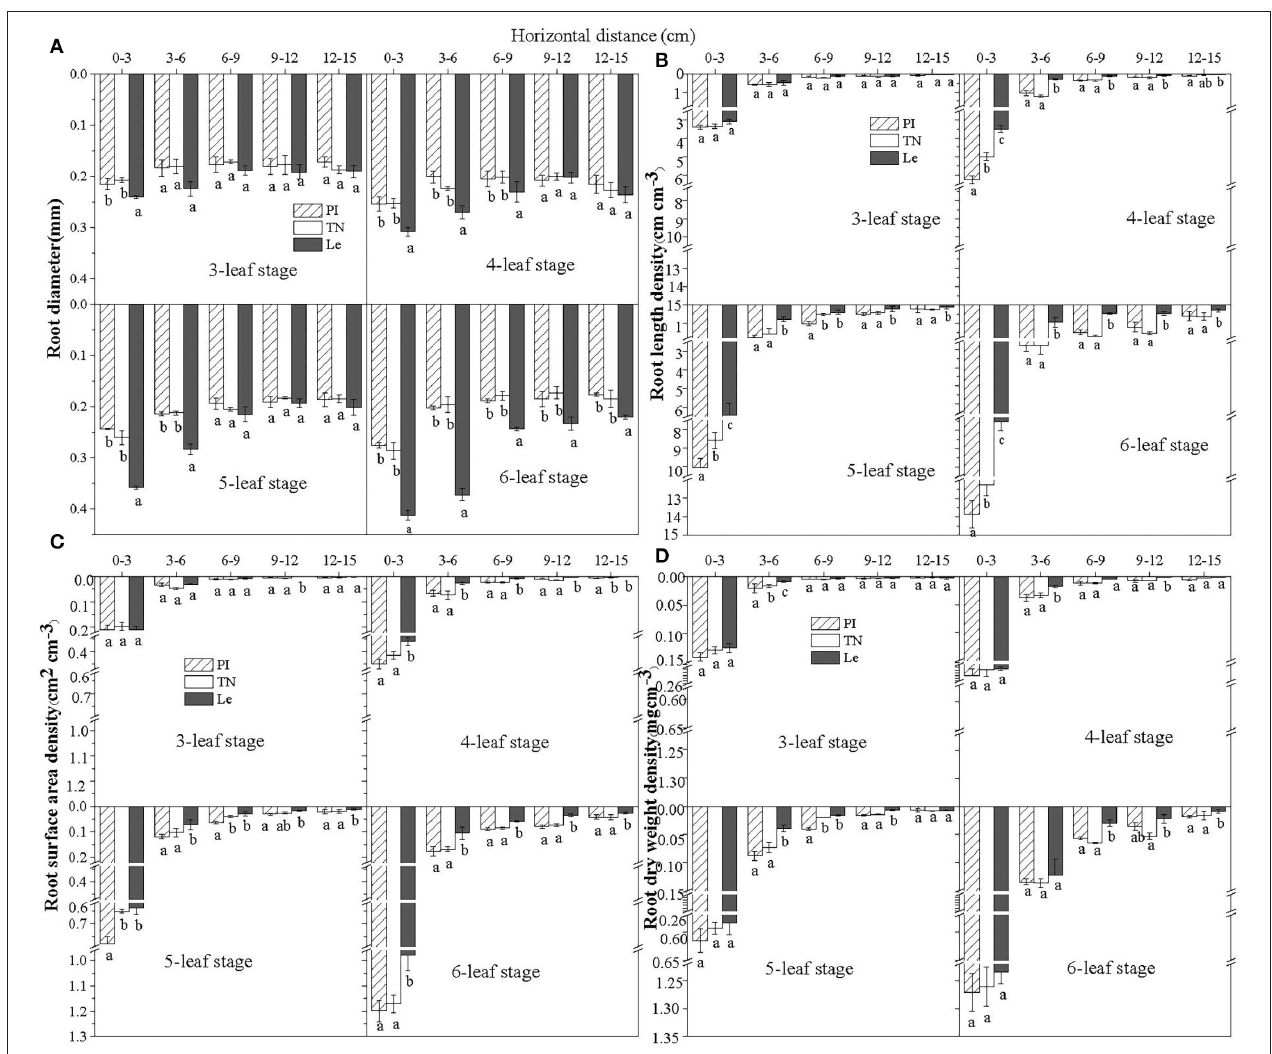
FIGURE 2 | Root diameter (A) , root length density (B) , root surface area density (C) , and root dry weight density (D) of three rice cultivars at different horizontal distances from the base of rice seedlings in the 0–5cm soil depth at the seedling stages. PI: allelopathic rice PI312777, TN: allelopathic rice Taichung Native1, and Le: non-allelopathic rice Lemont. Error bars indicate standard deviation. Significant differences ( p < 0.05) between rice cultivars at the same distance were indicated by different lowercase letters, according to Tukey’s honestly significant difference